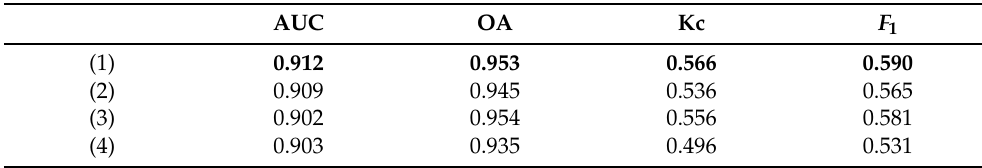
Table 7. Ablation study on the California